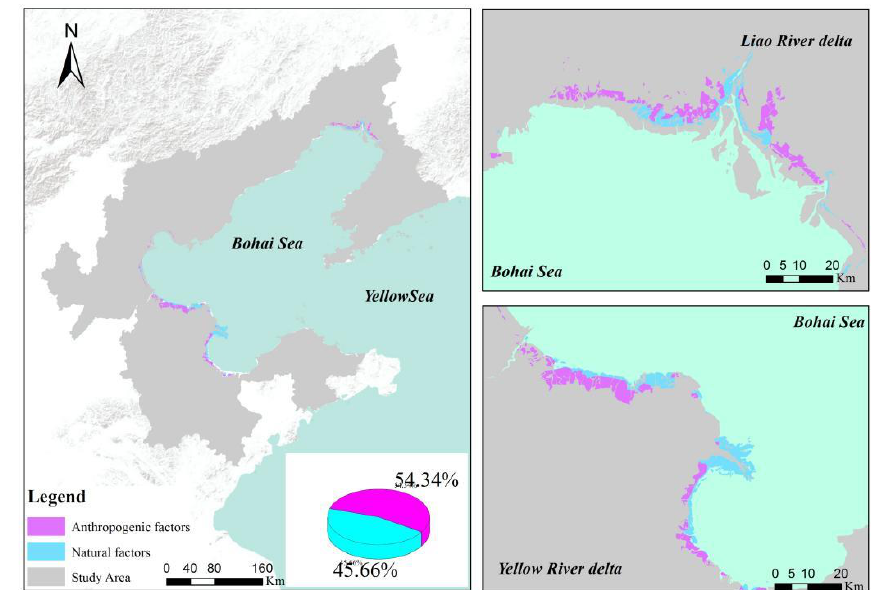
Figure 10. Influencing factors for the S. salsa changes in the study area.